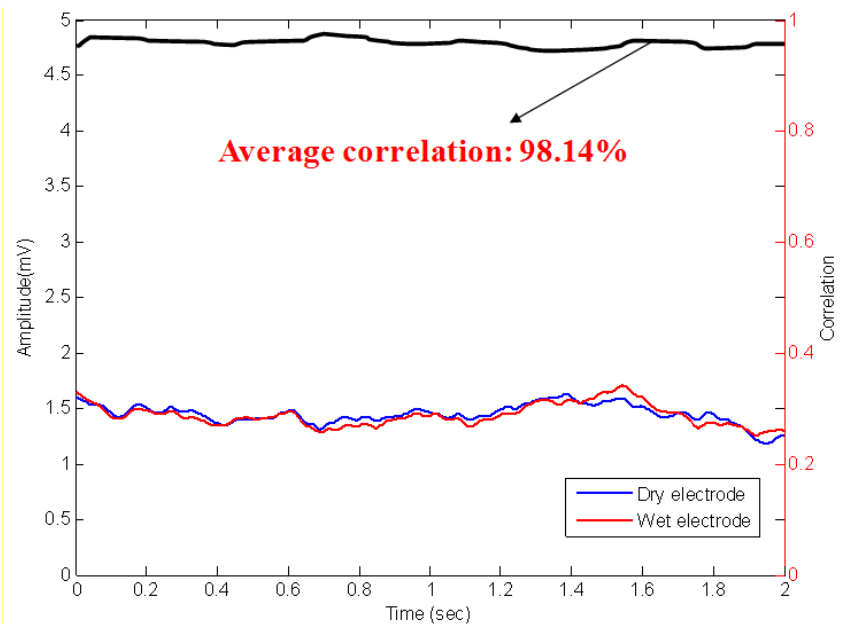
Figure 8. Prerecorded EEG and corresponding signals recorded by the dry EEG